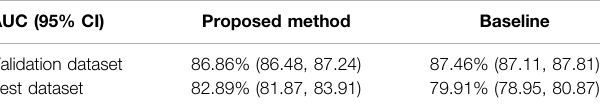
outliers, and the bottom 10% do not provide training value for the model, which will result in a poor model generalization.